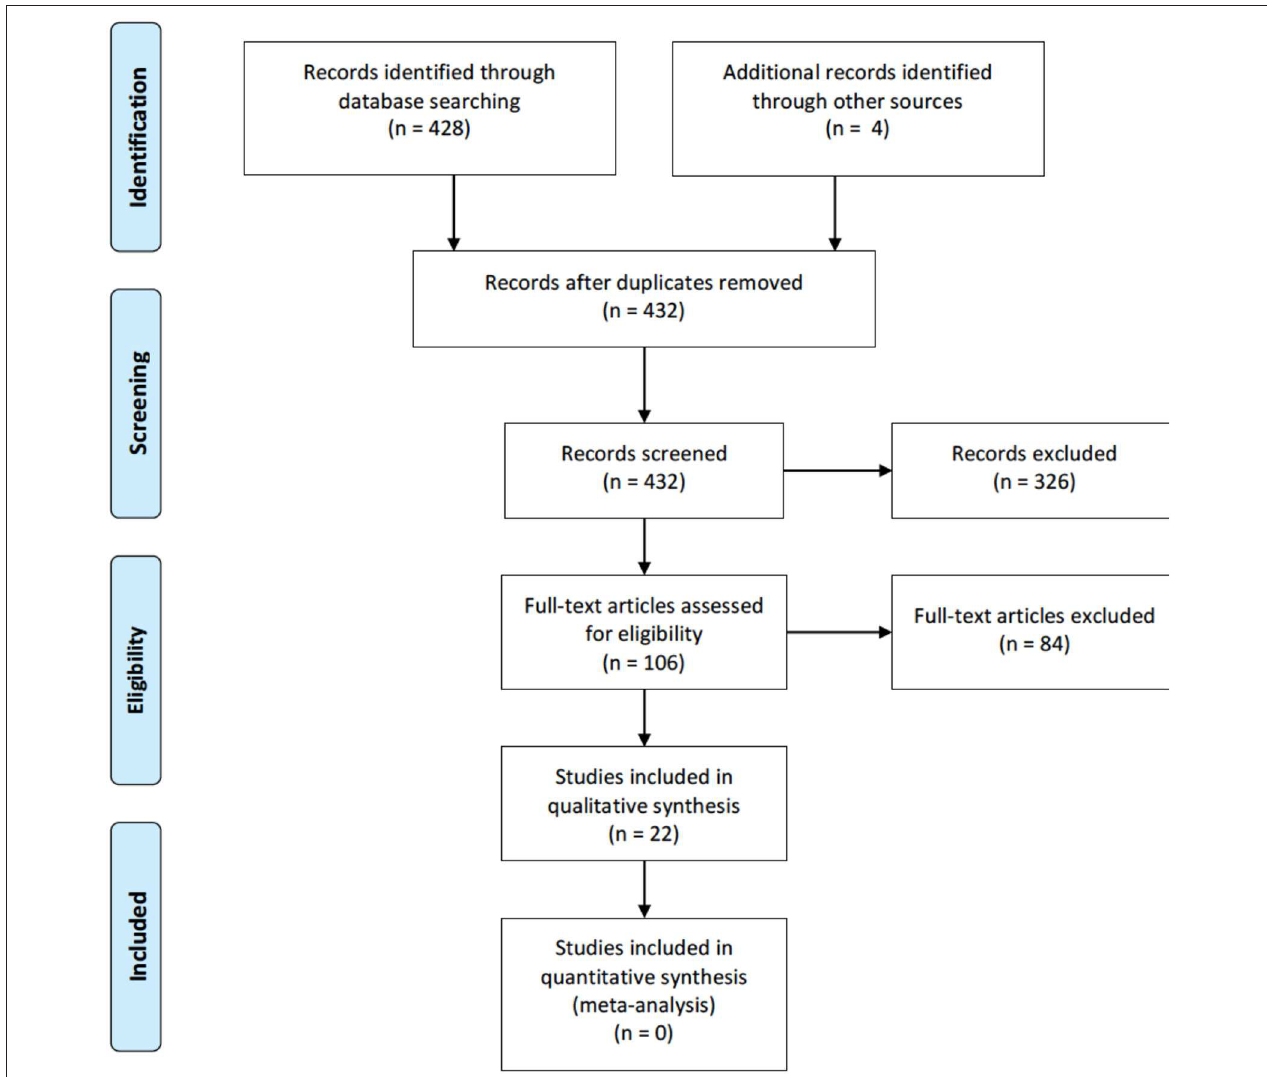
FIGURE 1 | PRISMA flow